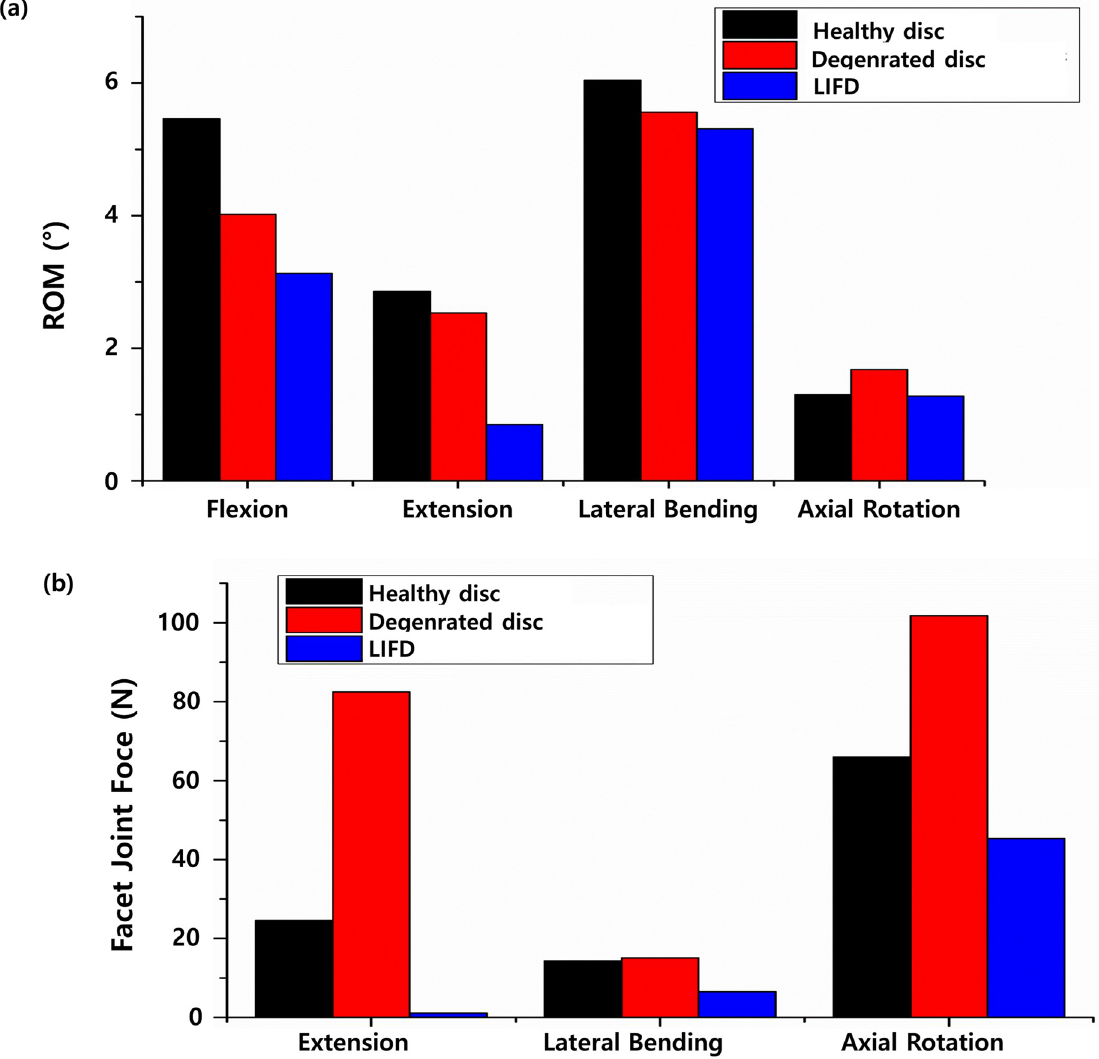
Fig 10. Finite element analysis results of the healthy L3-L4 lumbar spine, the degenerative L3-L4 with degenerative disc disease, the L3-L4 lumbar spine inserted by the lumbar interspinous fixation device (LIFD) in flexion (1175-N follower load and 7.5- N � m moment), extension (500 N follower load and 7.5 N � m moment), lateral bending (700 N follower load and 7.8 N � m moment), and axial rotation motion (720 N follower load and 5.5 N � m moment): (a) range of motion (ROM) (b) facet joint force (FJF).